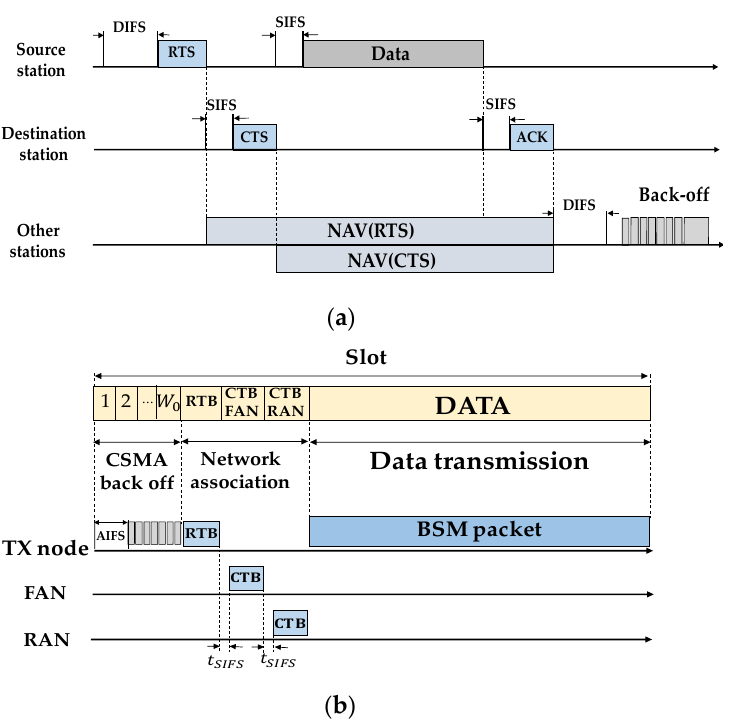
Figure 3. ( a ) IEEE 802.11′s collision avoidance scheme in unicast scenario using request-to-send/clear-to-send (RTS/CTS)/data/acknowledgement (ACK); ( b ) proposed collision avoidance scheme in broadcast scenario using three phases in each TDMA slot. Table 1. Brief description of notations.